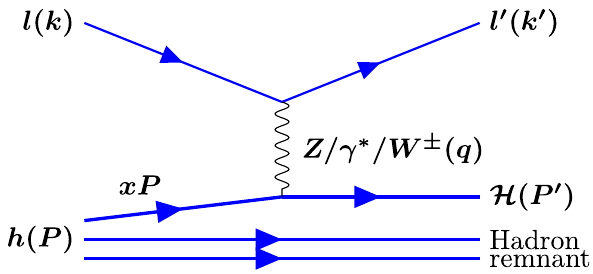
Fig. 1 Schematic representation of Deep Inelastic Scattering process at Born level